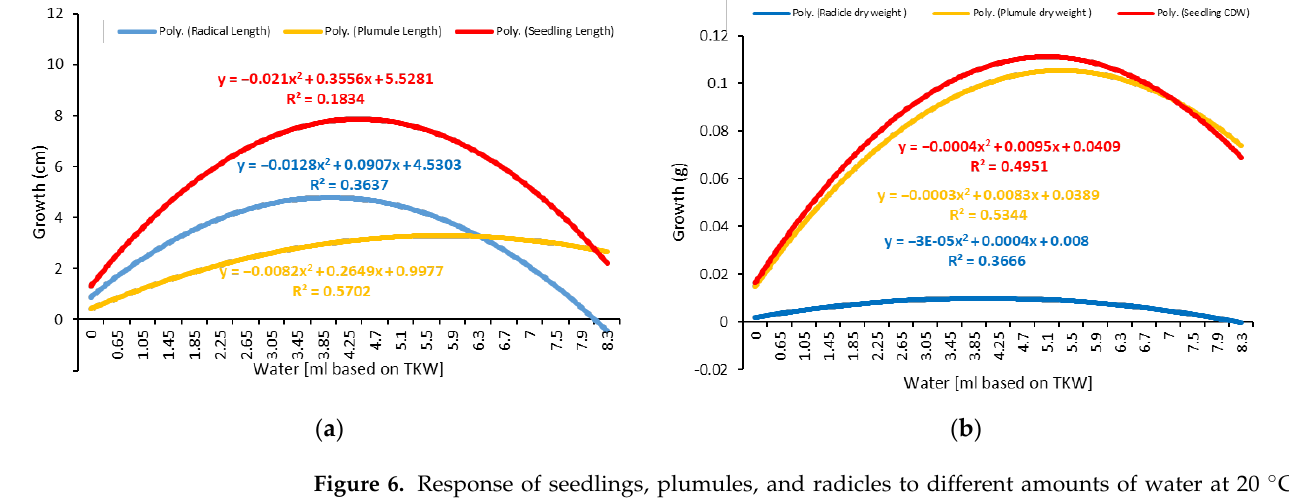
Figure 6. Response of seedlings, plumules, and radicles to different amounts of water at 20 °C. ( a ) Growth vs. water based on TKW%. ( b ) Dry weight accumulation vs. water based on TKW%.